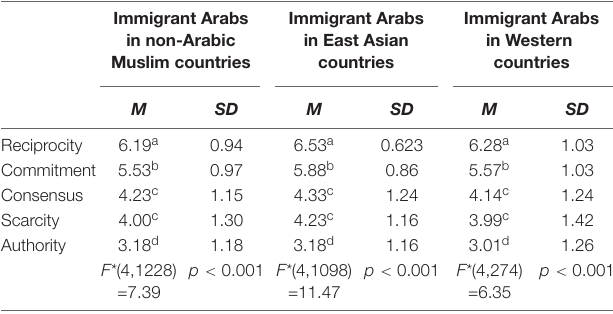
TABLE 5 | Post hoc RM-ANCOVAs and Bonferroni adjusted pairwise comparisons between the persuasion strategies among immigrant